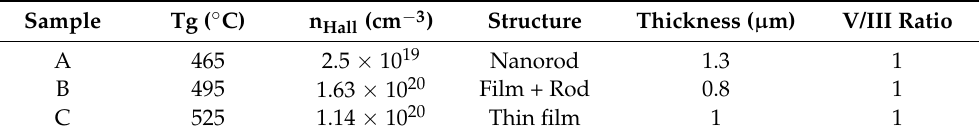
Table 1. Detail sample parameters: n Hall and Tg represent free carrier concentrations and InN growth temperatures, respectively. n Hall is carrier concentration measured by RT Hall measurements. Thickness is observed from SEM